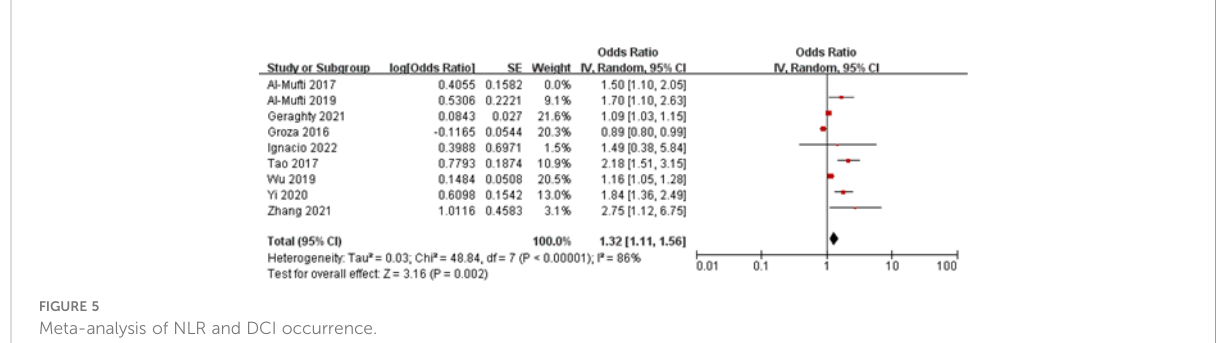
FIGURE 5 Meta-analysis of NLR and DCI occurrence.